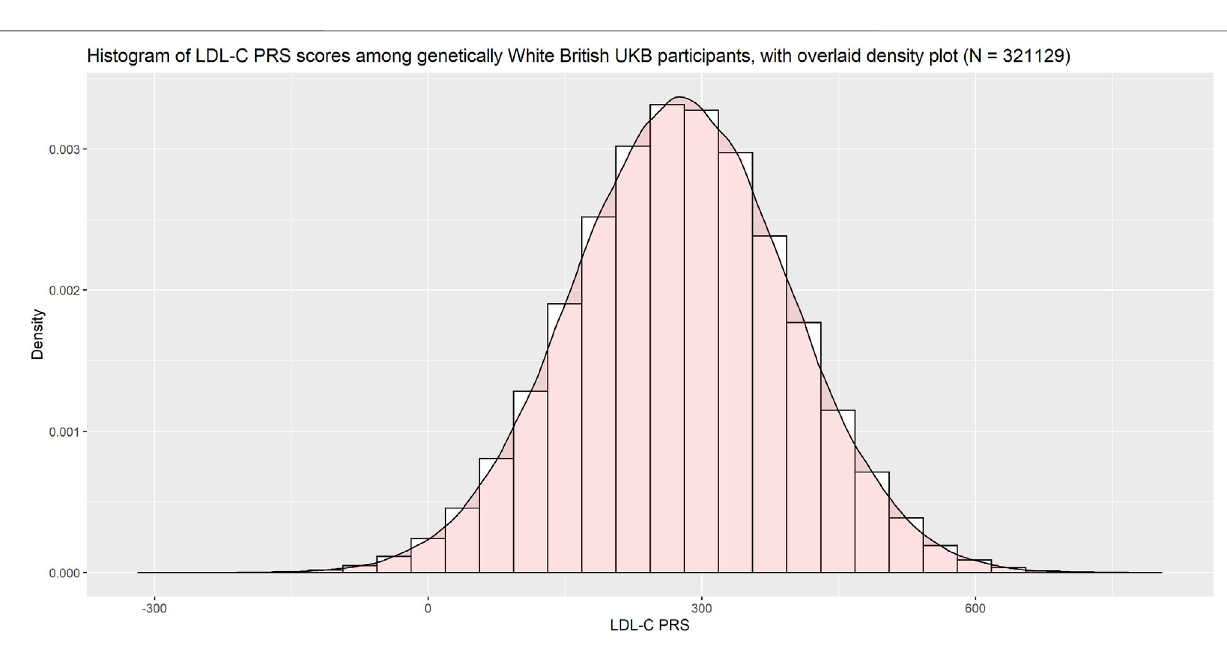
FIGURE 5 | Histogram of LDL-C PRS with overlaid density